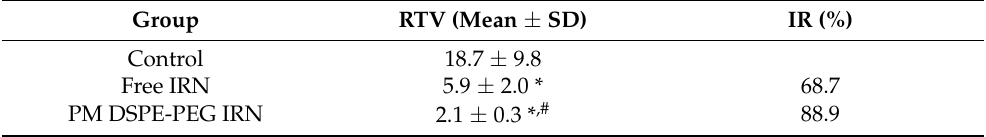
Table 3. Relative tumor volume (RTV) and tumor growth inhibition ratio (IR) after the administration of saline (control), free IRN, and PM DSPE-PEG